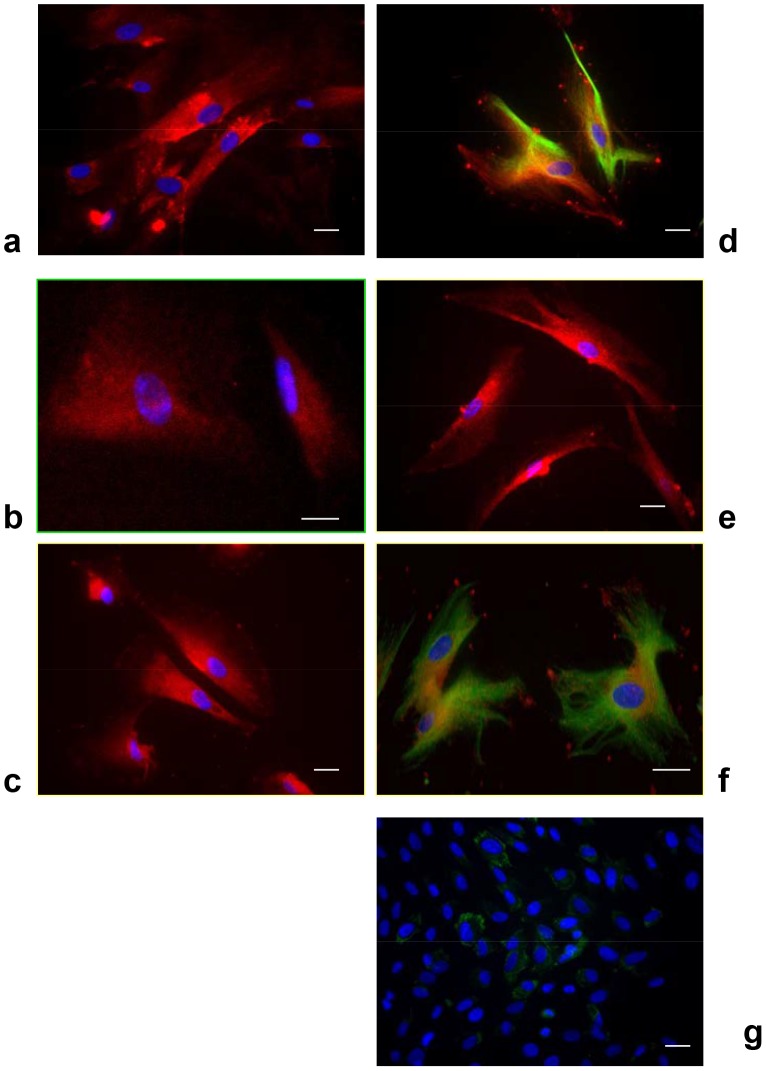
Immunofluorescence analyses of DPSCs committed to several cell lineages.(A) CD31 for endothelial cells (red cells). (B) Osteonectin for osteogenic commitment. (C) S100 (red cells, for neurogenic commitment), (D) nestin (red fibers) and βIII tubulin (green), (E) GFAP (red staining), (F) CNPase (green) and nestin (red) (40×) for glial-like commitment. (G) Negative control: DPSCs cultured in non-differentiative medium and stained with primary Ab against GFAP (no red-positive cell are detectable) and primary Ab against CNPase (no green-positive cells are detectable). Bar: 30 µm.